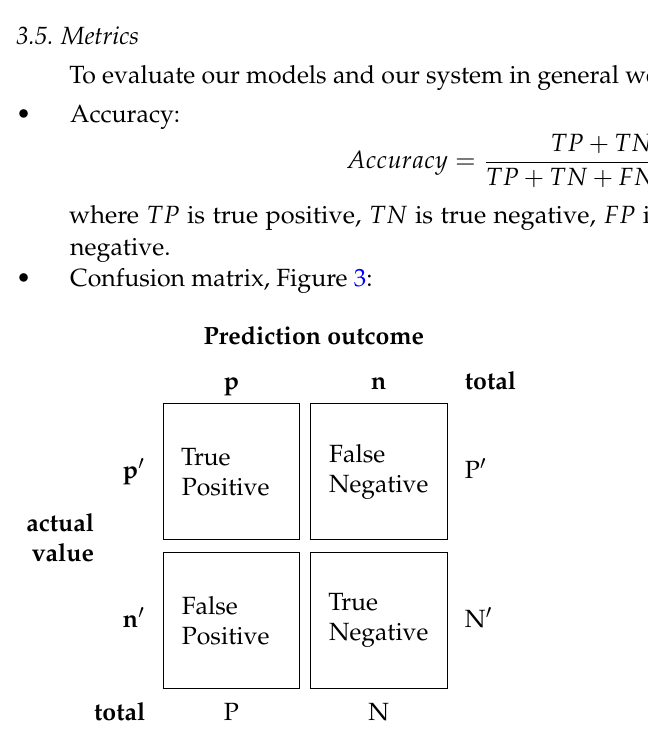
Figure 3. Exampleof confusion